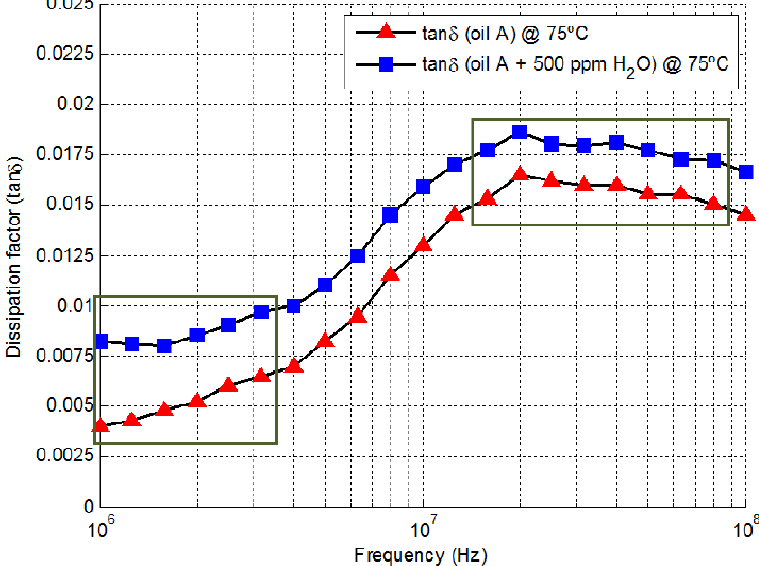
Figure 4. tan δ sweep for a lubricant without water contamination and contaminated with